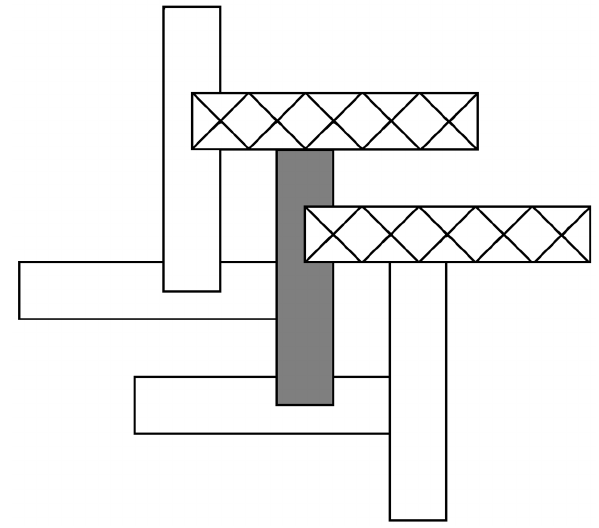
Scheme 5. Envelope stacking diagram for the title compound.